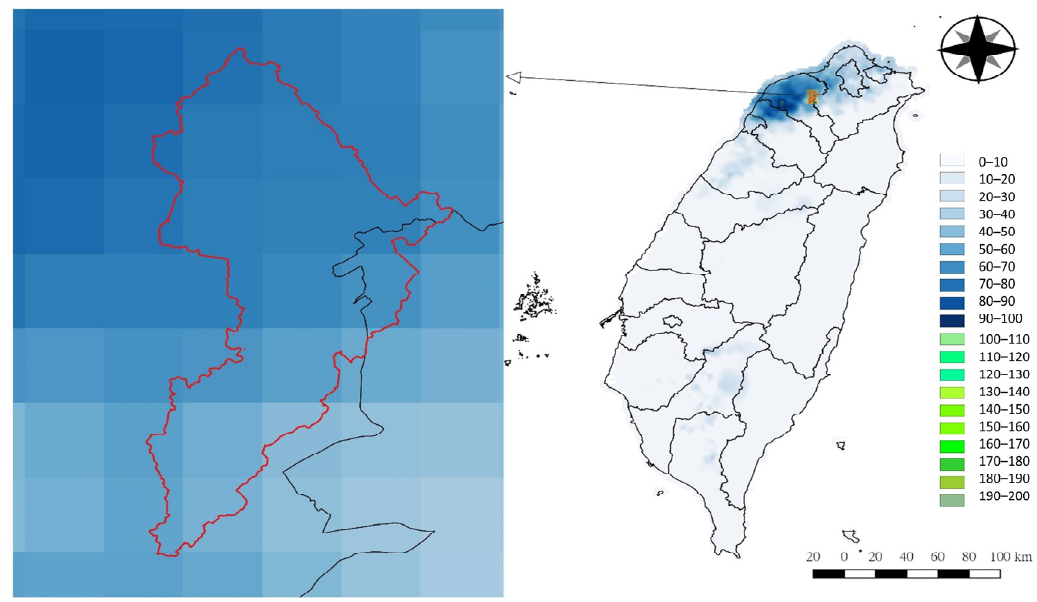
Figure 4. Time series and spatial of color-classified rainfall map datasets in 10 mm increments.